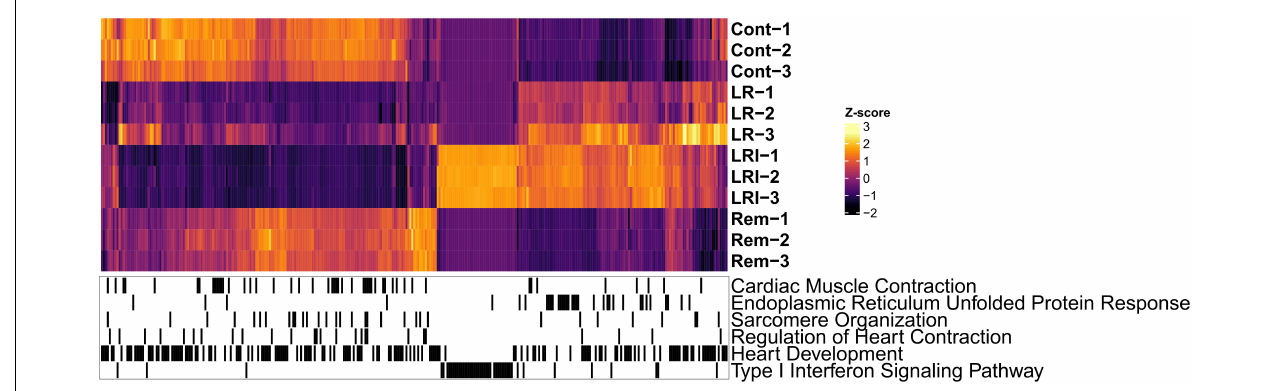
FIGURE 3 | Global map of Gene Ontology (GO) functional enrichments after LR, LRI, and Rem treatment. Heatmap based on TPM-normalized RNA-seq data (orange: high expression, purple: low expression) for differentially expressed genes between control and LR, LRI, or Rem (FDR ≤ 0.05, | Log2 fold change ≥ 0.5|). Below, black lines indicate genes associated with the respective GO category. TPM: Transcripts Per Kilobase Million. LR: lopinavir/ritonavir; LRI: lopinavir/ritonavir + interferon- β ; Rem: